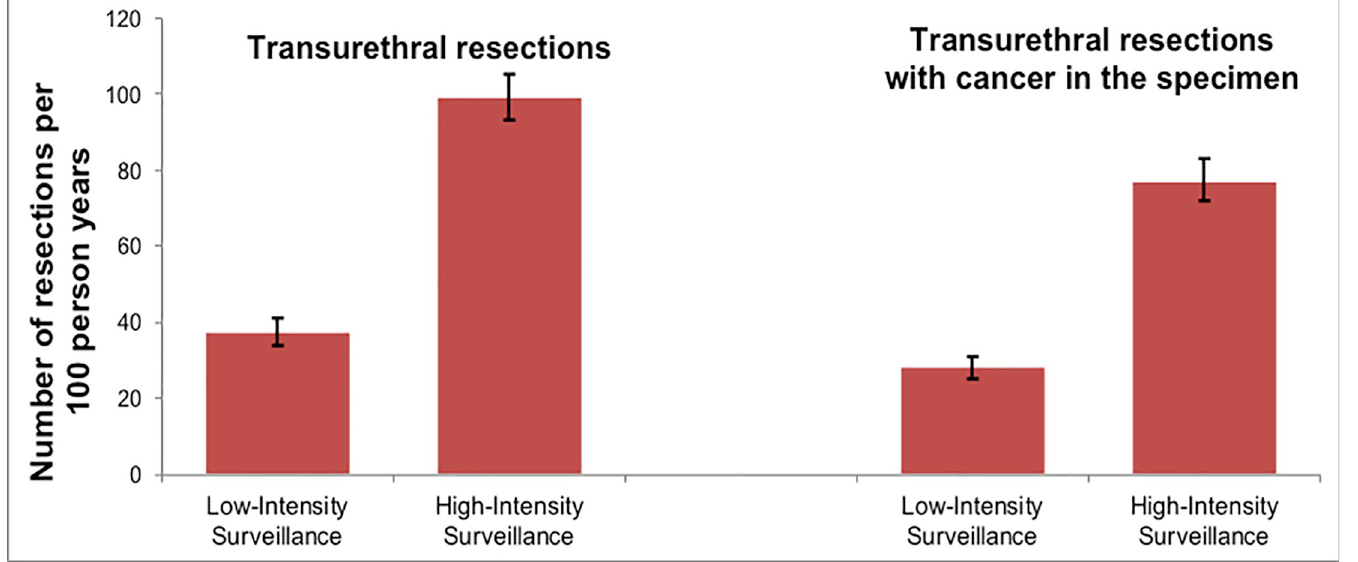
Fig 4. Number of total transurethral resctions and resections with cancer in the pathology specimen by low versus high-intensity surveillance. Patients who underwent low-intensity surveillance experienced 3-times fewer total transurethral resections and resection with cancer in the specimen compared to high-intensity surveillance